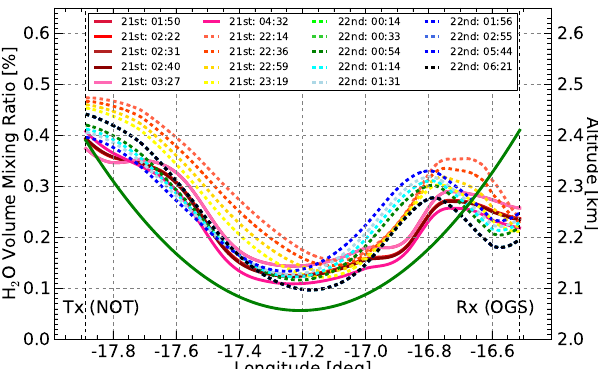
Figure 3. H 2 O volume mixing ratio along the Tx-to-Rx ray path (longitude coordinate shown) based on interpolated ECMWF anal- ysis fields, for ray-tracing performed at the starting time of each IR-laser link data file (Table 2). In addition, the altitude of the ray path above mean sea level is indicated (thick green line; right-hand- side axis), which, due to Earth’s curvature over the 144km distance, is more than 300m lower at mid-distance than the altitudes of the Tx and Rx